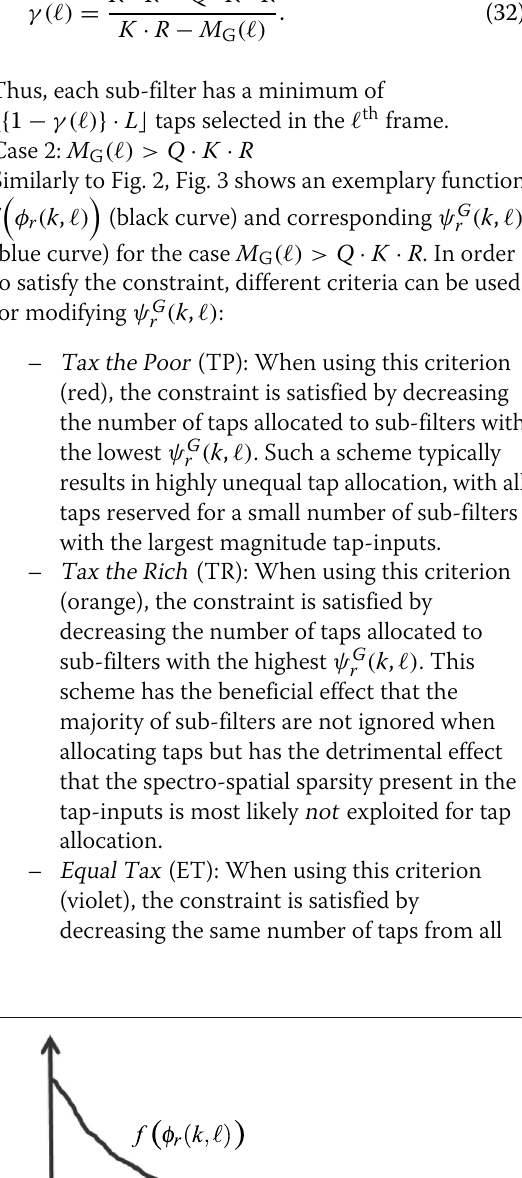
(cid:15) (cid:16) φ ( k , (cid:2)) and corresponding ψ G r ( k , (cid:2)) , r